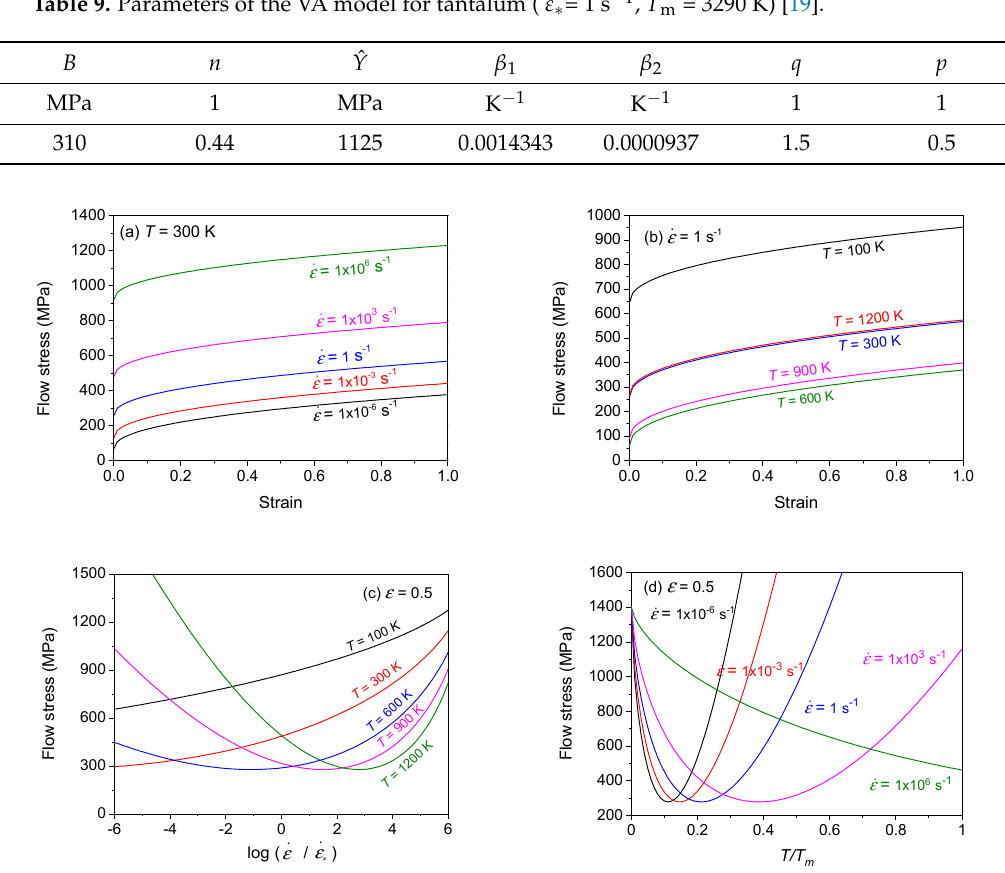
Figure 18. Flow stress–strain curves predicted for tantalum using the VA model ( a ) at 300 K for different strain rates and ( b ) at 𝜀(cid:4662) = 1 for different temperatures. Change in flow stress at 𝜀 = 0.5 ( c ) with log ( 𝜀(cid:4662) / 𝜀(cid:4662) ∗ ) for different temperatures and ( d ) with T / T m for different strain rates ( 𝜀(cid:4662) ∗ = 1 s − 1 , T m = 3290 K).